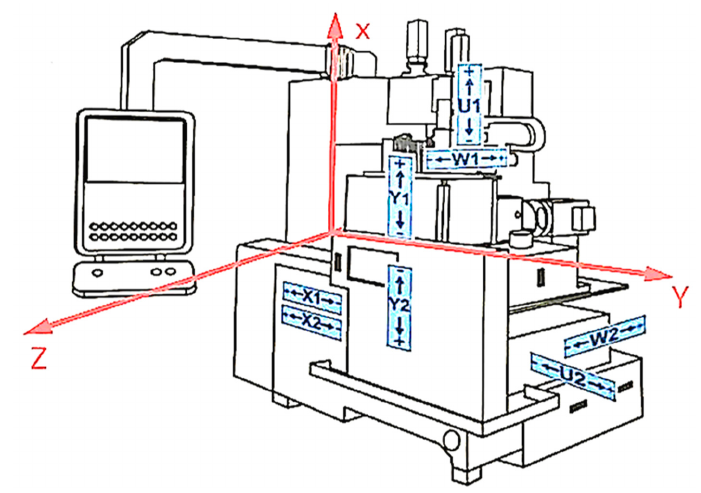
Figure 9. Schematic drawing of the sensor axis directions to the Nomoco device.